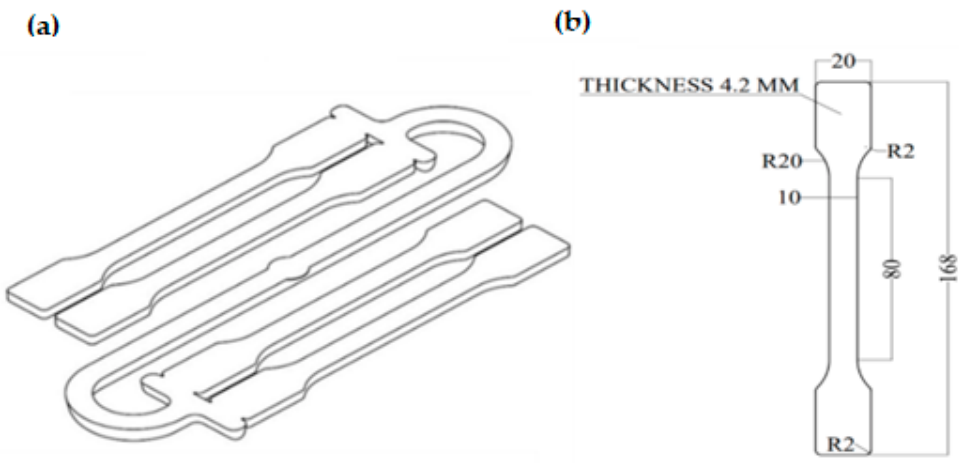
Figure 2. Model of the injection mold cavity ( a ) and a single test sample ( b ).